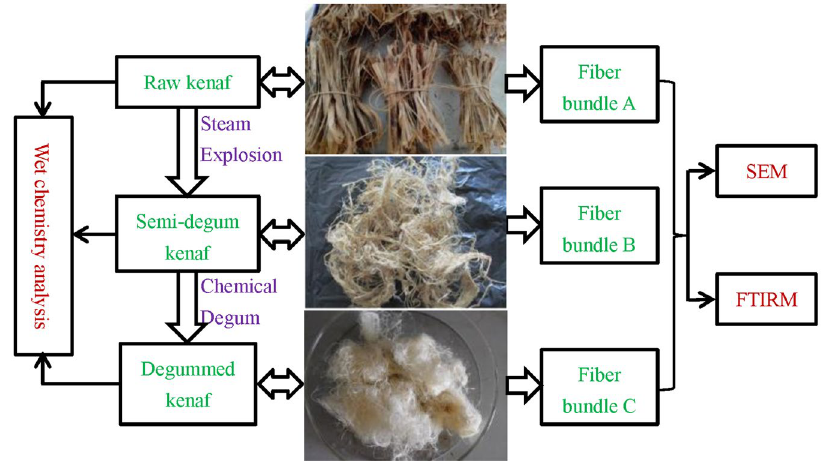
Figure 5. Schematic diagram for the